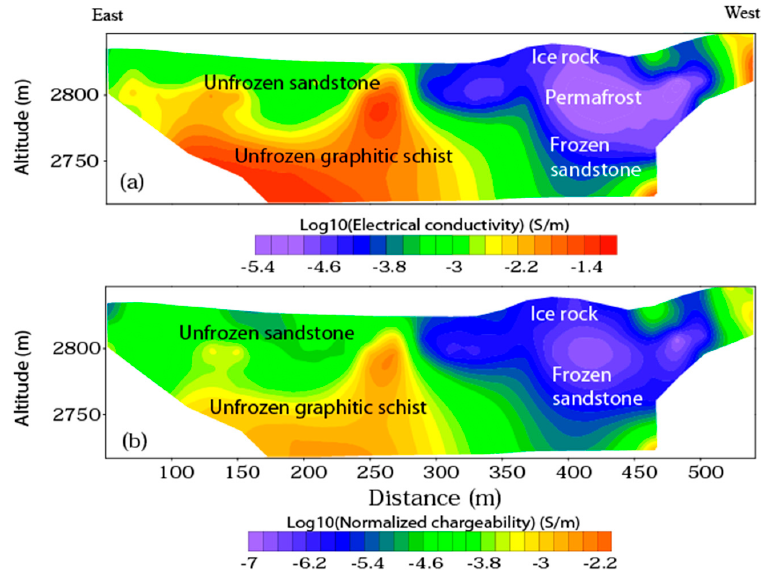
Figure 30. Large ‐ scale electrical conductivity and normalized chargeability tomograms crossing an area that is associated with a rock glacier with permafrost below it. ( a ) Electrical conductivity tomogram showing position and depth of the permafrost (about 70 m). ( b ) Normalized chargeability tomogram (high normalized chargeability zones correlated with graphitic schist formation). The frozen area is in blue. Modified from [43].